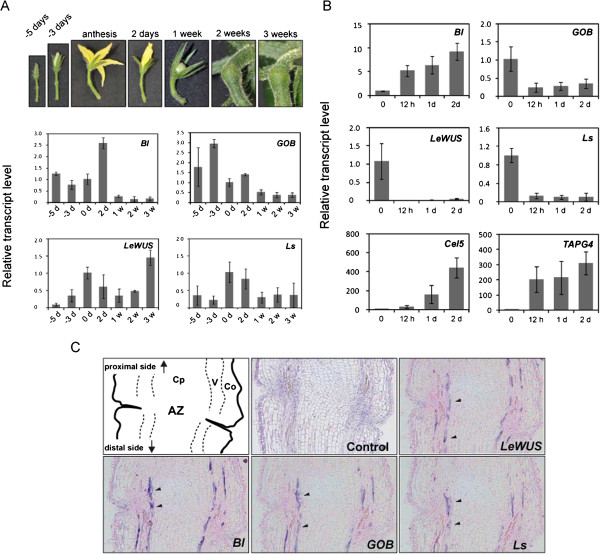
Expression of Bl, GOB, LeWUS and Ls in tomato pedicels. (A) Expression of Bl, GOB, LeWUS and Ls during pedicel development. Expression of the genes in pedicels at 5 and 3 days before anthesis, at anthesis and at 2 days to 3 weeks after anthesis was examined by qRT-PCR. Levels of transcripts of each gene are shown as fold-change values compared to the sample harvested at anthesis. (B) Expression of Bl, GOB, LeWUS and Ls in response to an abscission stimulus. Anthesis flowers were removed from the pedicels to induce abscission and then the pedicel AZs were harvested at 0 hours, 12 hours, 1 day and 2 days after flower removal. The expression of Bl, GOB, LeWUS and Ls was examined by qRT-PCR. Error bars indicate standard deviation of biological triplicates. At 1 day after flower removal, approximately 10% of pedicels were abscised and then the rate increased to 36% at 2 days after (Additional file 8). Both attached and detached pedicels were examined simultaneously. As positive controls, expression analyses were performed for Cel5 and TAPG4, which are up-regulated after flower removal [27]. Levels of transcripts of each gene are shown as fold-change values compared to the 0 hour sample. Error bars indicate standard deviation of biological triplicates. (C) Expression of Bl, GOB, Ls, and LeWUS in a flower pedicel AZ at anthesis. Dig-labeled antisense probes were hybridized to serial sections of a pedicel AZ at anthesis. Transcripts of these genes, indicated by arrowheads, were found in several lines of cells within the vascular bundles. The upper left panel is a schematic of an AZ. The control section was stained with a hematoxylin and eosin stain solution. AZ; abscission zone, Co; Cortex, V; Vascular bundle, and Cp; Central parenchyma.